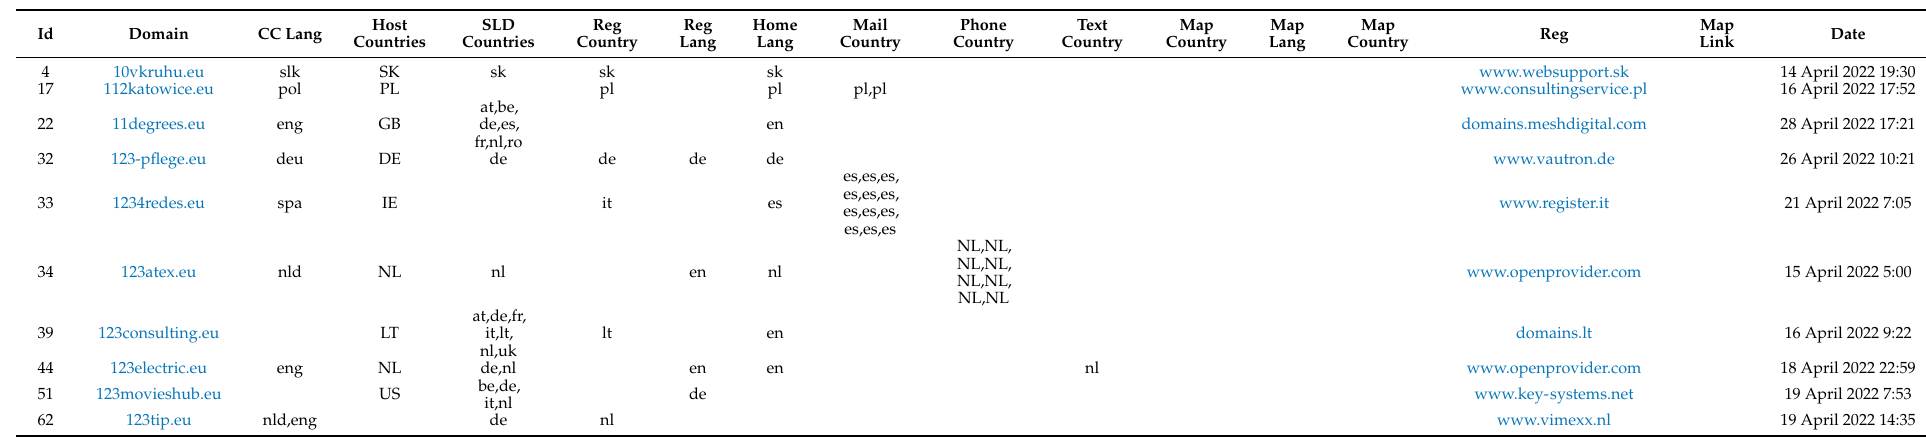
Table 4. Sample of data collected by the Web data extraction